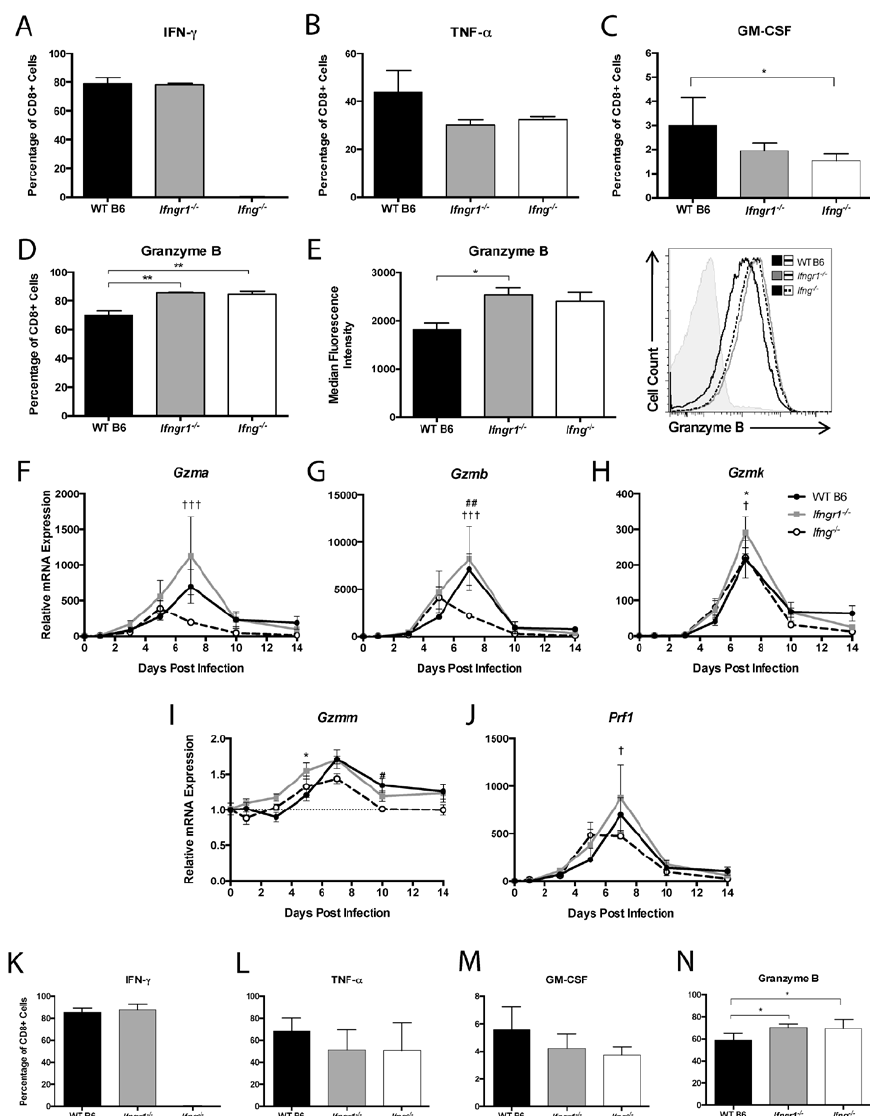
Figure 9. CD8 + T cell function during SINV infection in WT, Ifngr1 − / − , and Ifng − / − mouse brains and spinal cords. ( A – D ) Flow cytometry was used to evaluate the percentage of CD8 + T cells producing IFN- γ ( A ), TNF- α ( B ), GM-CSF ( C ), and granzyme B ( D ) in the brains of WT (black bars), Ifngr1 − / − (gray bars), and Ifng − / − (white bars) mice at 7 DPI. ( E ) MFI presented in graph form ( left ) and as a histogram ( right ) was used to evaluate the amount of granzyme B produced by individual CD8 + T cells among strains ( n = 3–9 pooled mice per strain per time point from 3–4 independent experiments; * p < 0.05, ** p < 0.01 by Dunn’s multiple comparisons test). ( F – J ) Relative mRNA expression of granzyme A ( F ), granzyme B ( G ), granzyme K ( H ), granzyme M ( I ), and perforin ( J ) were examined by qRT-PCR in WT (black circle and solid line), Ifngr1 − / − (gray square and solid line), and Ifng − / − (white circle and black dashed line) mouse brains ( n = 3–4 mice per strain per time point; data are presented as the mean ± SEM; dashed line indicates gene expression of 0 DPI tissue for each strain to which other time points were normalized; * p < 0.05, WT vs. Ifngr1 − / − ; ## p < 0.01, WT vs. Ifng − / − , † p < 0.05, ††† p < 0.001, Ifngr1 − / − vs. Ifng − / − , all by Tukey’s multiple comparisons test). ( K – N ) Flow cytometry was used to evaluate the percentage of CD8 + T cells producing IFN- γ ( K ), TNF- α ( L ), GM-CSF ( M ), and granzyme B ( N ) in the spinal cords of WT, Ifngr1 − / − , and Ifng − / − mice at 7 DPI. ( n = 6–9 pooled mice per strain per time point from five independent experiments; * p < 0.05, by Dunn’s multiple comparisons